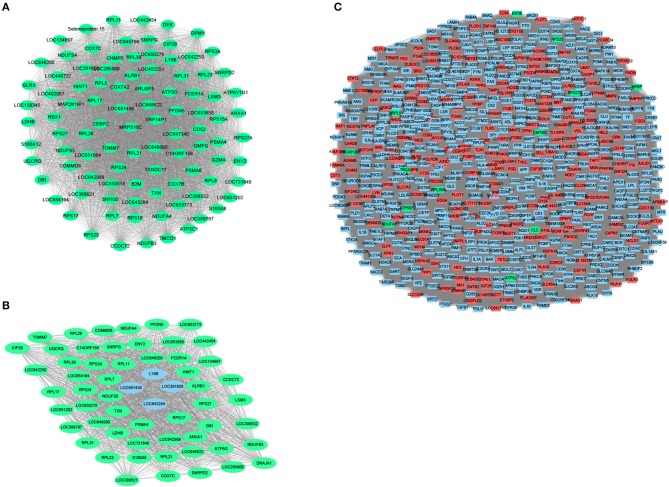
Module network construction. (A) The network diagram of the MCI blue module (green for down-regulated genes, red for up-regulated genes). (B) The network diagram of the AD blue module (green for down-regulated genes, red for up-regulated genes). (C) The network diagram of the AD turquoise module (green for down-regulated genes, red for up-regulated genes).